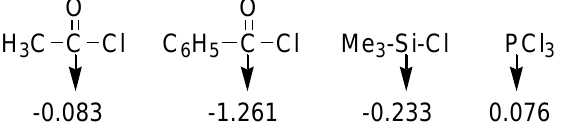
Figure 4. Fukui functions calculated at the B3LYP/6-31+G* level.